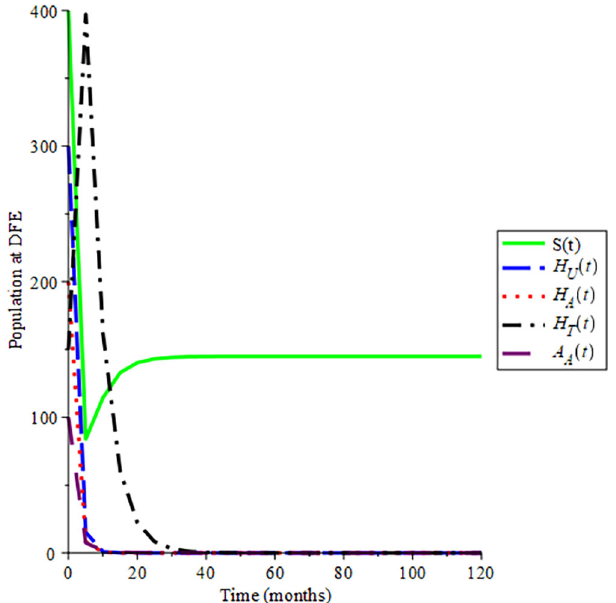
Figure 2. Proportion of different population of HIV at DFE when R 0 <